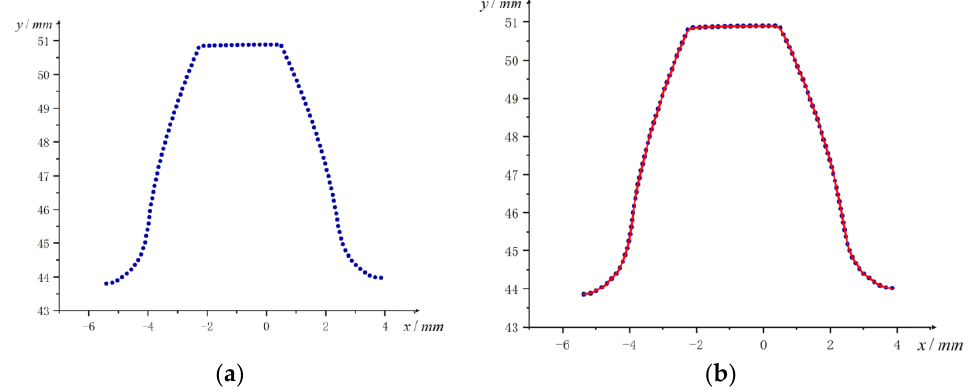
Figure 9. Establishment of the actual tooth profile curve, ( a ) scatter point of tooth profile coordinates, and ( b ) the B-spline fitting tooth profile curve.